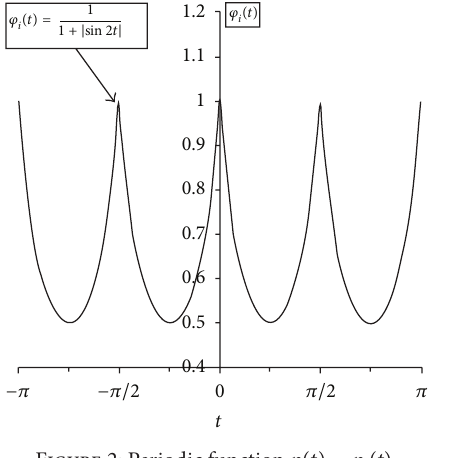
Figure 2: Periodic function 𝜑(𝑡) = 𝜑 𝑖 (𝑡)